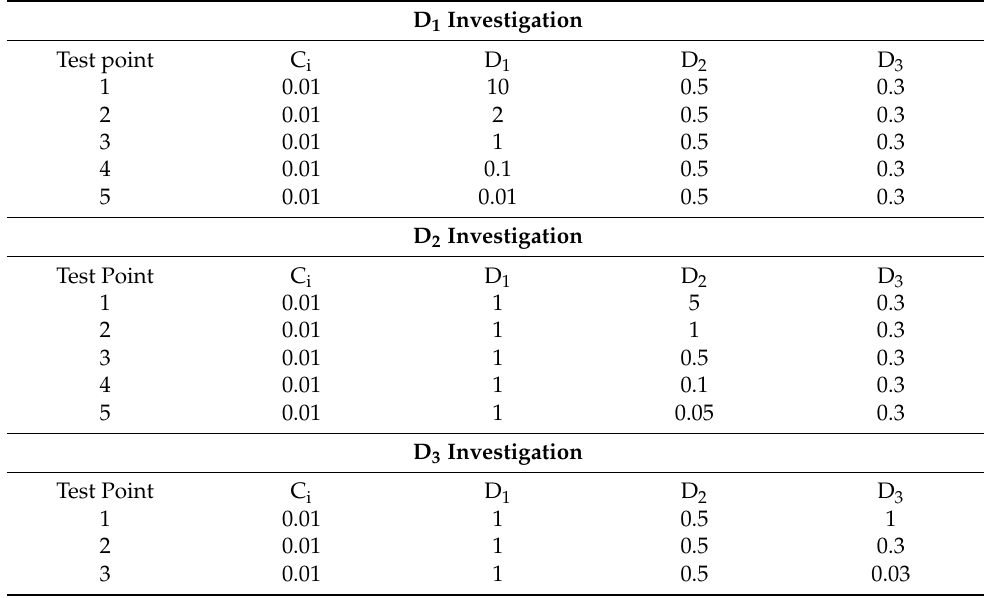
Table 7. Investigated values of the D-parameters in the MRD